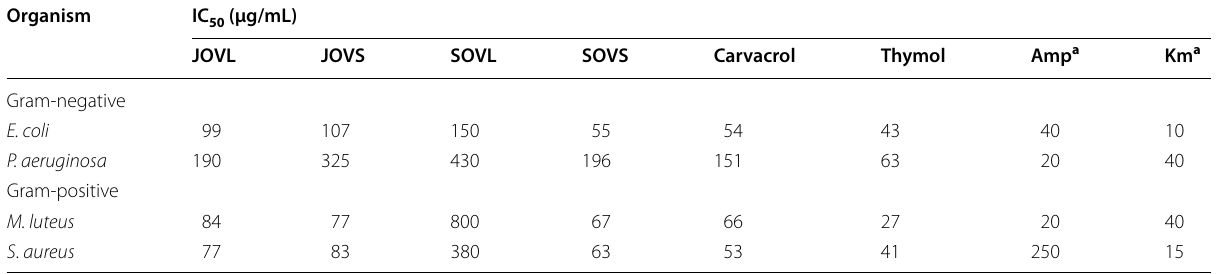
Table 2 The IC values obtained with different samples against Gram-negative and Gram-positive 50